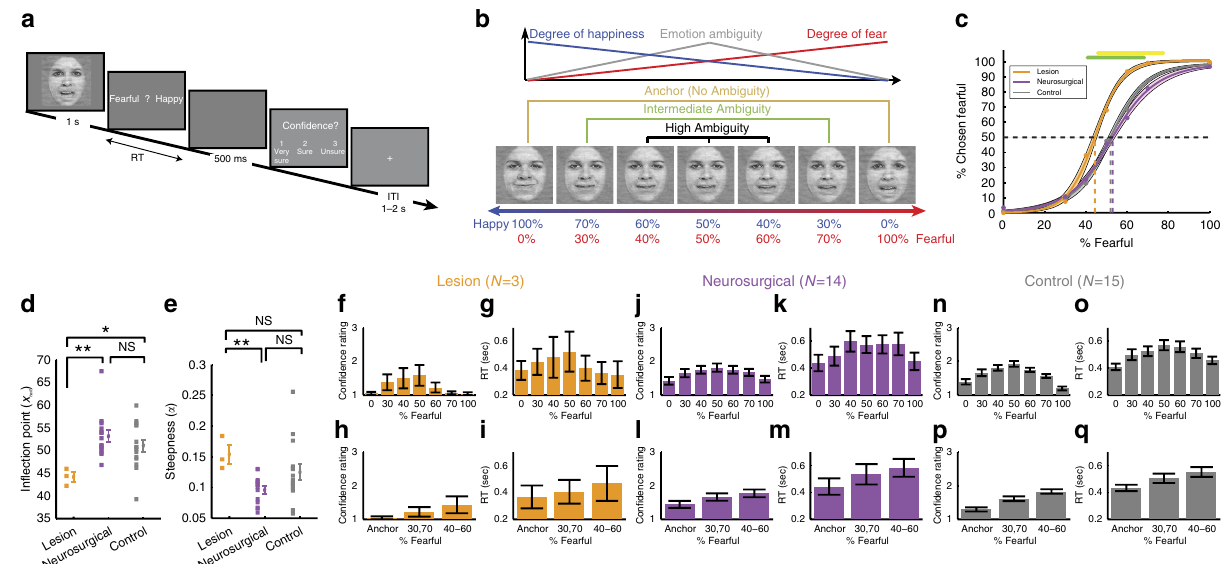
Figure 1 | Behavioural results. ( a ) Task. A face was presented for 1s followed by a question asking subjects to identify the facial emotion (fearful or happy). After a blank screen of 500ms, subjects were then asked to indicate their confidence in their decision (‘1’ for ‘very sure’, ‘2’ for ‘sure’ or ‘3’ for ‘unsure’). Faces are not shown to scale. ( b ) Sample stimuli of one female identity ranging from 0% fear/100% happy to 100% fear/0% happy. ( c – q ) Behavioural results. ( c ) Group average of psychometric curves. The psychometric curves show the proportion of trials judged as fearful as a function of morph levels (ranging from 0% fearful (100% happy; on the left) to 100% fearful (0% happy; on the right)). Shaded area denotes ± s.e.m. across subjects/sessions ( n ¼ 3, 14, 15). The top bars illustrate the points with significant difference between amygdala lesion patients and neurosurgical patients (green; unpaired two-tailed t -test, P o 0.05, corrected by FDR for Q o 0.05) and between amygdala lesion patients and healthy controls (yellow). ( d ) Inflection point of the logistic function ( x half ). ( e ) Steepness of the psychometric curve ( a ). Individual values are shown on the left and average values are shown on the right. Error bars denote one s.e.m. across subjects/sessions. Asterisks indicate significant difference using unpaired two-tailed t -test. * P o 0.05, and ** P o